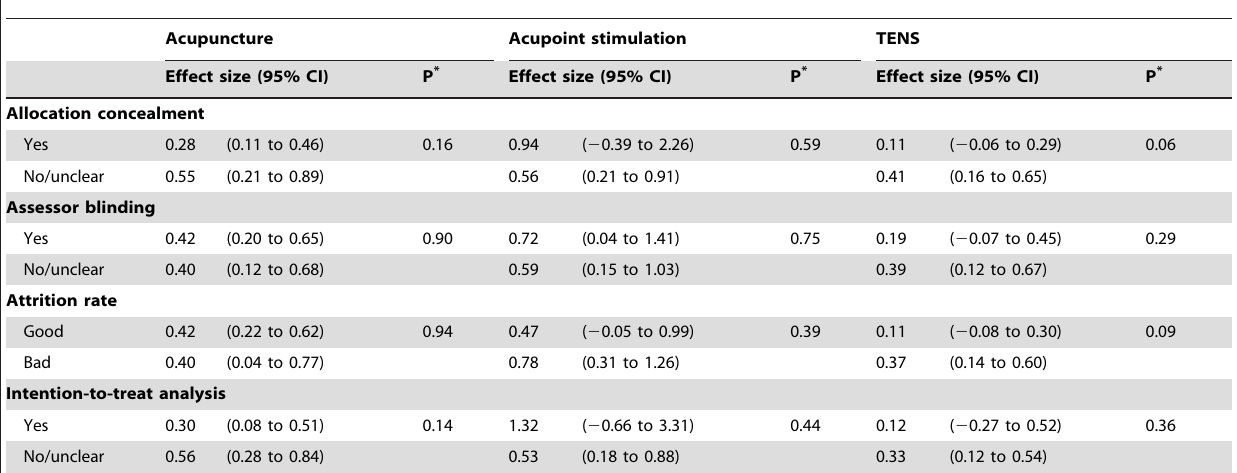
Table 4. Treatment effect of trials with or without methodological characteristics.